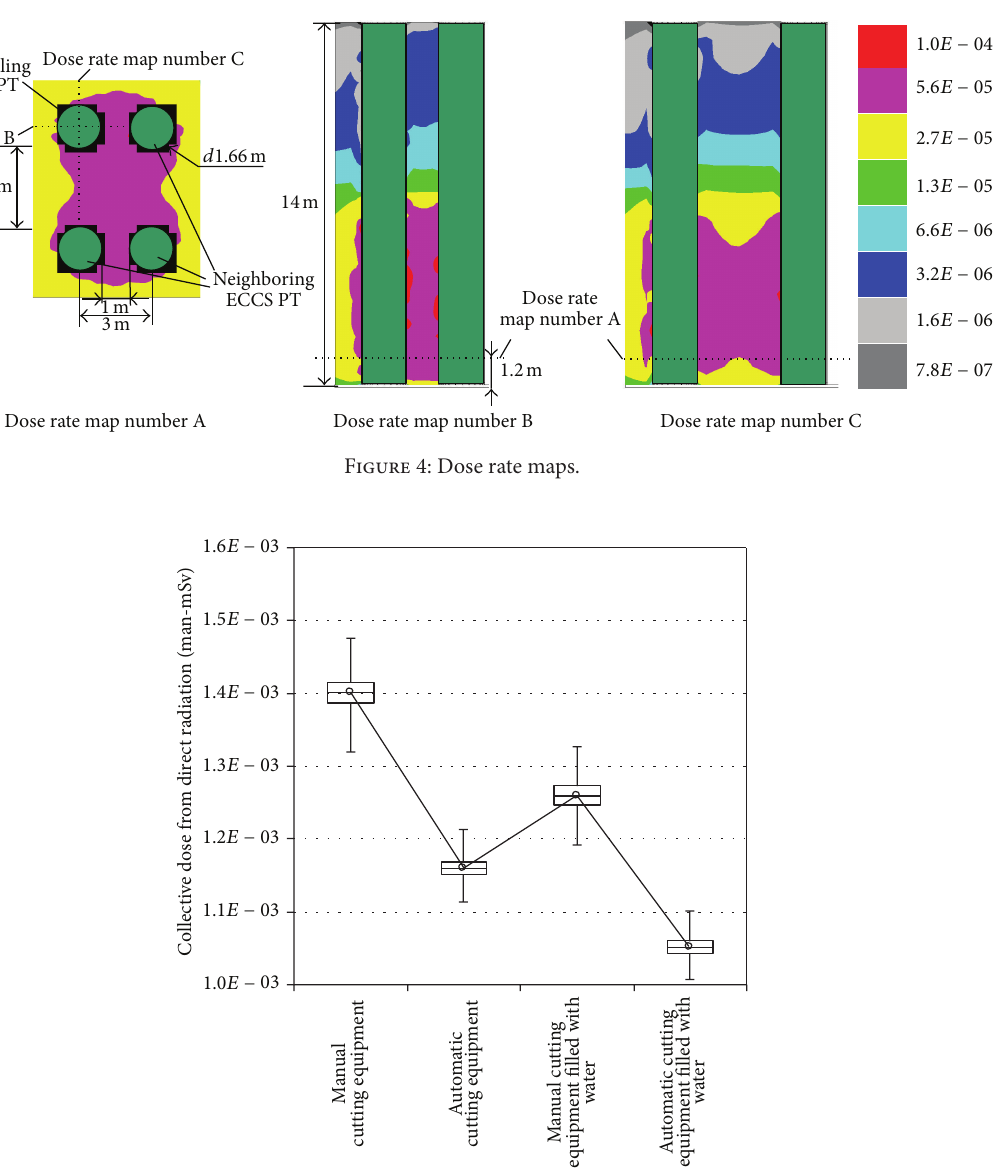
Figure 5: Whisker diagrams of collective dose from direct radiation (ends of whiskers present minimum and maximum values; circles present